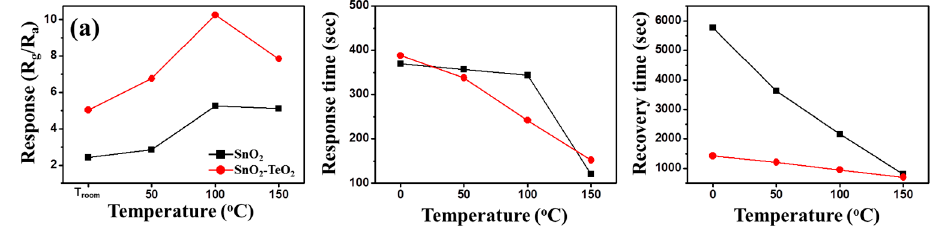
Figure 4. ( a ) Response curve of SnO 2 nanowires (Black) and TeO 2 branched SnO 2 nanowires (Red), ( b ) Response times and ( c ) Recovery times of SnO 2 nanowires and TeO 2 branched SnO 2